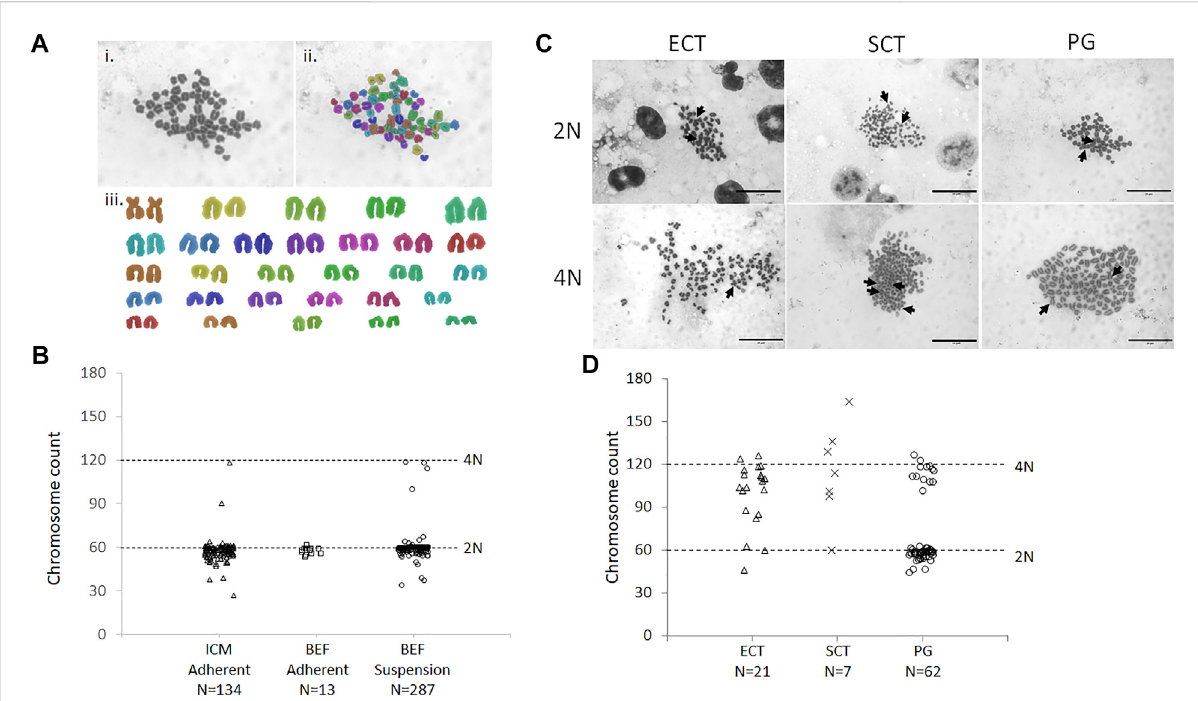
FIGURE 4 Karyotype of donor cells and ECT embryos. (A) Example karyotype of parthenogenetic embryo, containing 58 chromosomes, analyzed by SmartType. Image was taken at 1000× magni fi cation. i) Individual chromosomes outlined using SmartType. ii) Chromosomes falsely colored for identi fi cation in the karyotype. iii) Chromosome karyotype separated from the background and arranged according to size. Metacentric sex chromosomes (brown) are paired at the top right. (B) Distribution of chromosome spreads from ICM and bovine embryonic fi broblasts (BEF), obtained by either in situ adherent or standard suspension karyotyping. (C) Cloned blastocysts were generated from ICM (ECT) or BEF (SCT) donors, and chemically activated parthenogenotes (PG) served as controls. 2N (diploid) and 4N (tetraploid) indicate approximately 60 and 120 chromosome counts, respectively. Arrows indicate metacentric sex chromosomes. Scale bar = 20 μ m. (D) Distribution of chromosome spreads from cloned and PG embryos. Horizontal dashed lines indicate approximately diploid (60) and tetraploid (120) chromosome counts. N = number of metaphase spreads